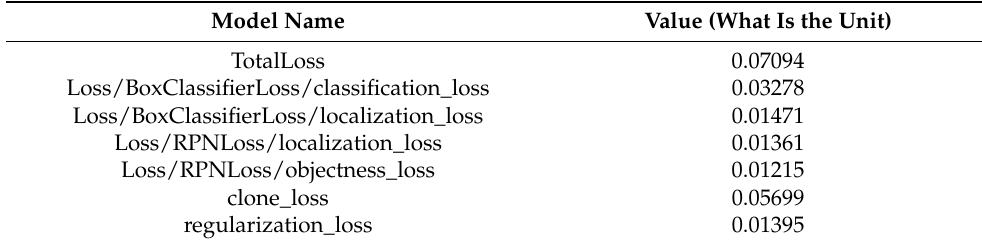
Table 3. The Faster R-CNN Inception v2 COCO trained model performance result.